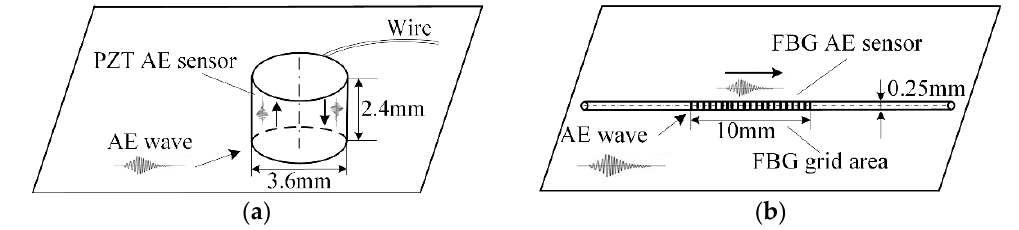
Figure 2. PZT and FBG AE sensor. ( a ) PZT AE sensor; ( b ) FBG AE sensor.